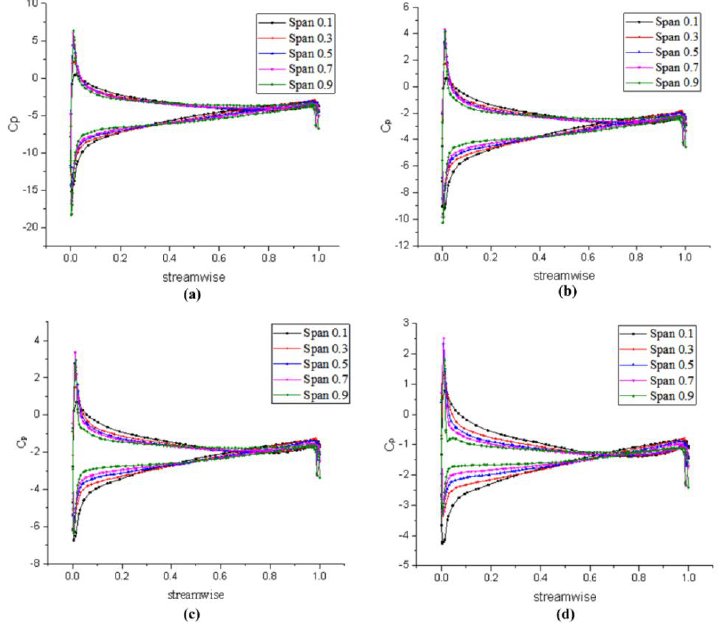
Figure 16. Tangential pressure distribution of the rotor designed by lifting method: ( a ) v = 7 m/s ( J = 0.78), ( b ) v = 8.5 m/s ( J = 0.95), ( c ) v = 10 m/s ( J = 1.12), and ( d ) v = 11.5 m/s ( J = 1.28).